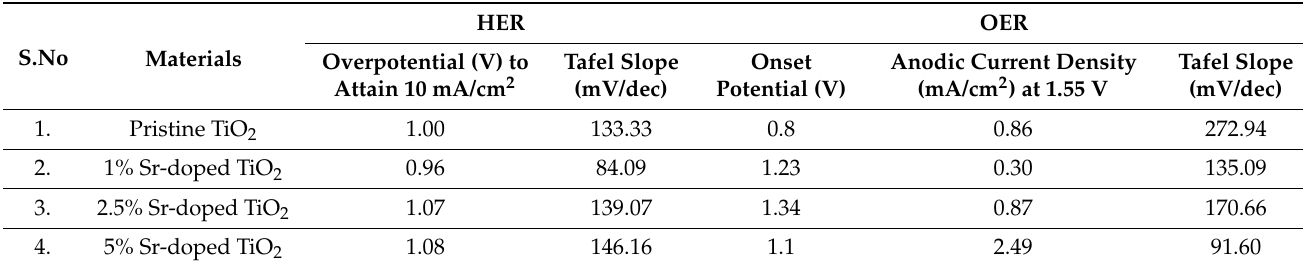
Figure 13. CA analysis at − 0.5 V and +0.5 V for 1% and 5% Sr-doped TiO 2 nanoparticles.